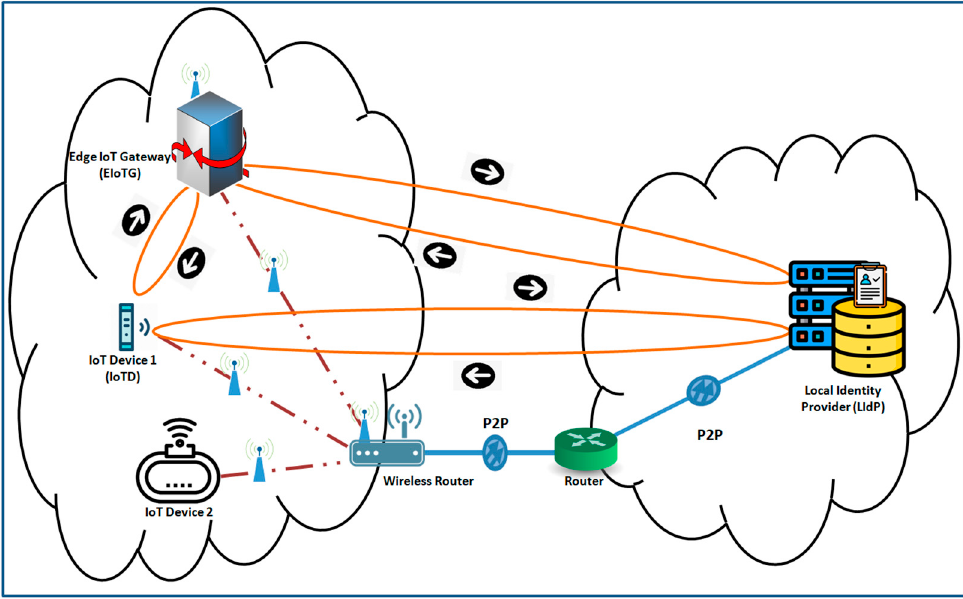
Figure 14. Identity management via LIdM when IoTD and EIoTG are at same network.